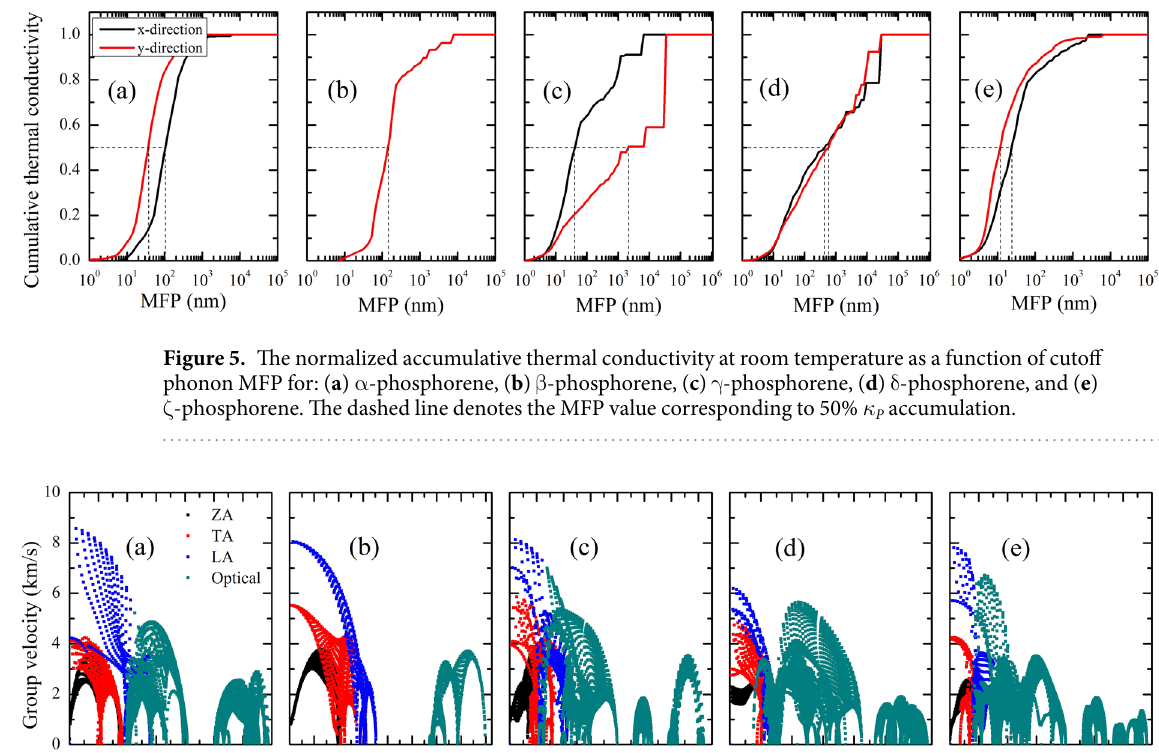
Figure 6. Room temperature group velocities of different phonon modes as a function of frequency for: ( a ) α -phosphorene, ( b ) β -phosphorene, ( c ) γ -phosphorene, ( d ) δ -phosphorene, and ( e ) ζ